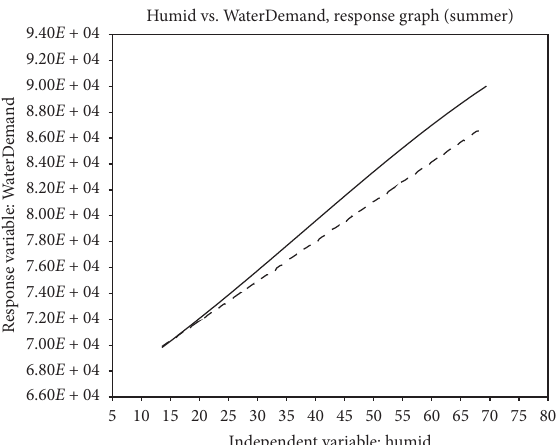
Figure 16: The reaction of water consumption to relative humidity with with summer conditions using GLM and SVM-Nu